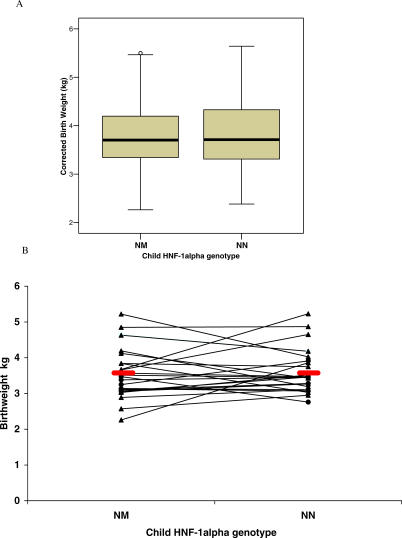
Birthweight in HNF1A-Mutation Carriers(A) Median centile (adjusted for sex and gestation) in mutation carriers (NM) and non-mutation carriers (NN) (p = 0.86). Error bars show interquartile range. (B) Discordant sib-pair analysis. Those pairs where the father has the mutation are shown as filled circles; those pairs where the mother has the mutation are shown as filled triangles. Median birthweight: NM 3,490 g; NN 3460 g (p = 0.91).